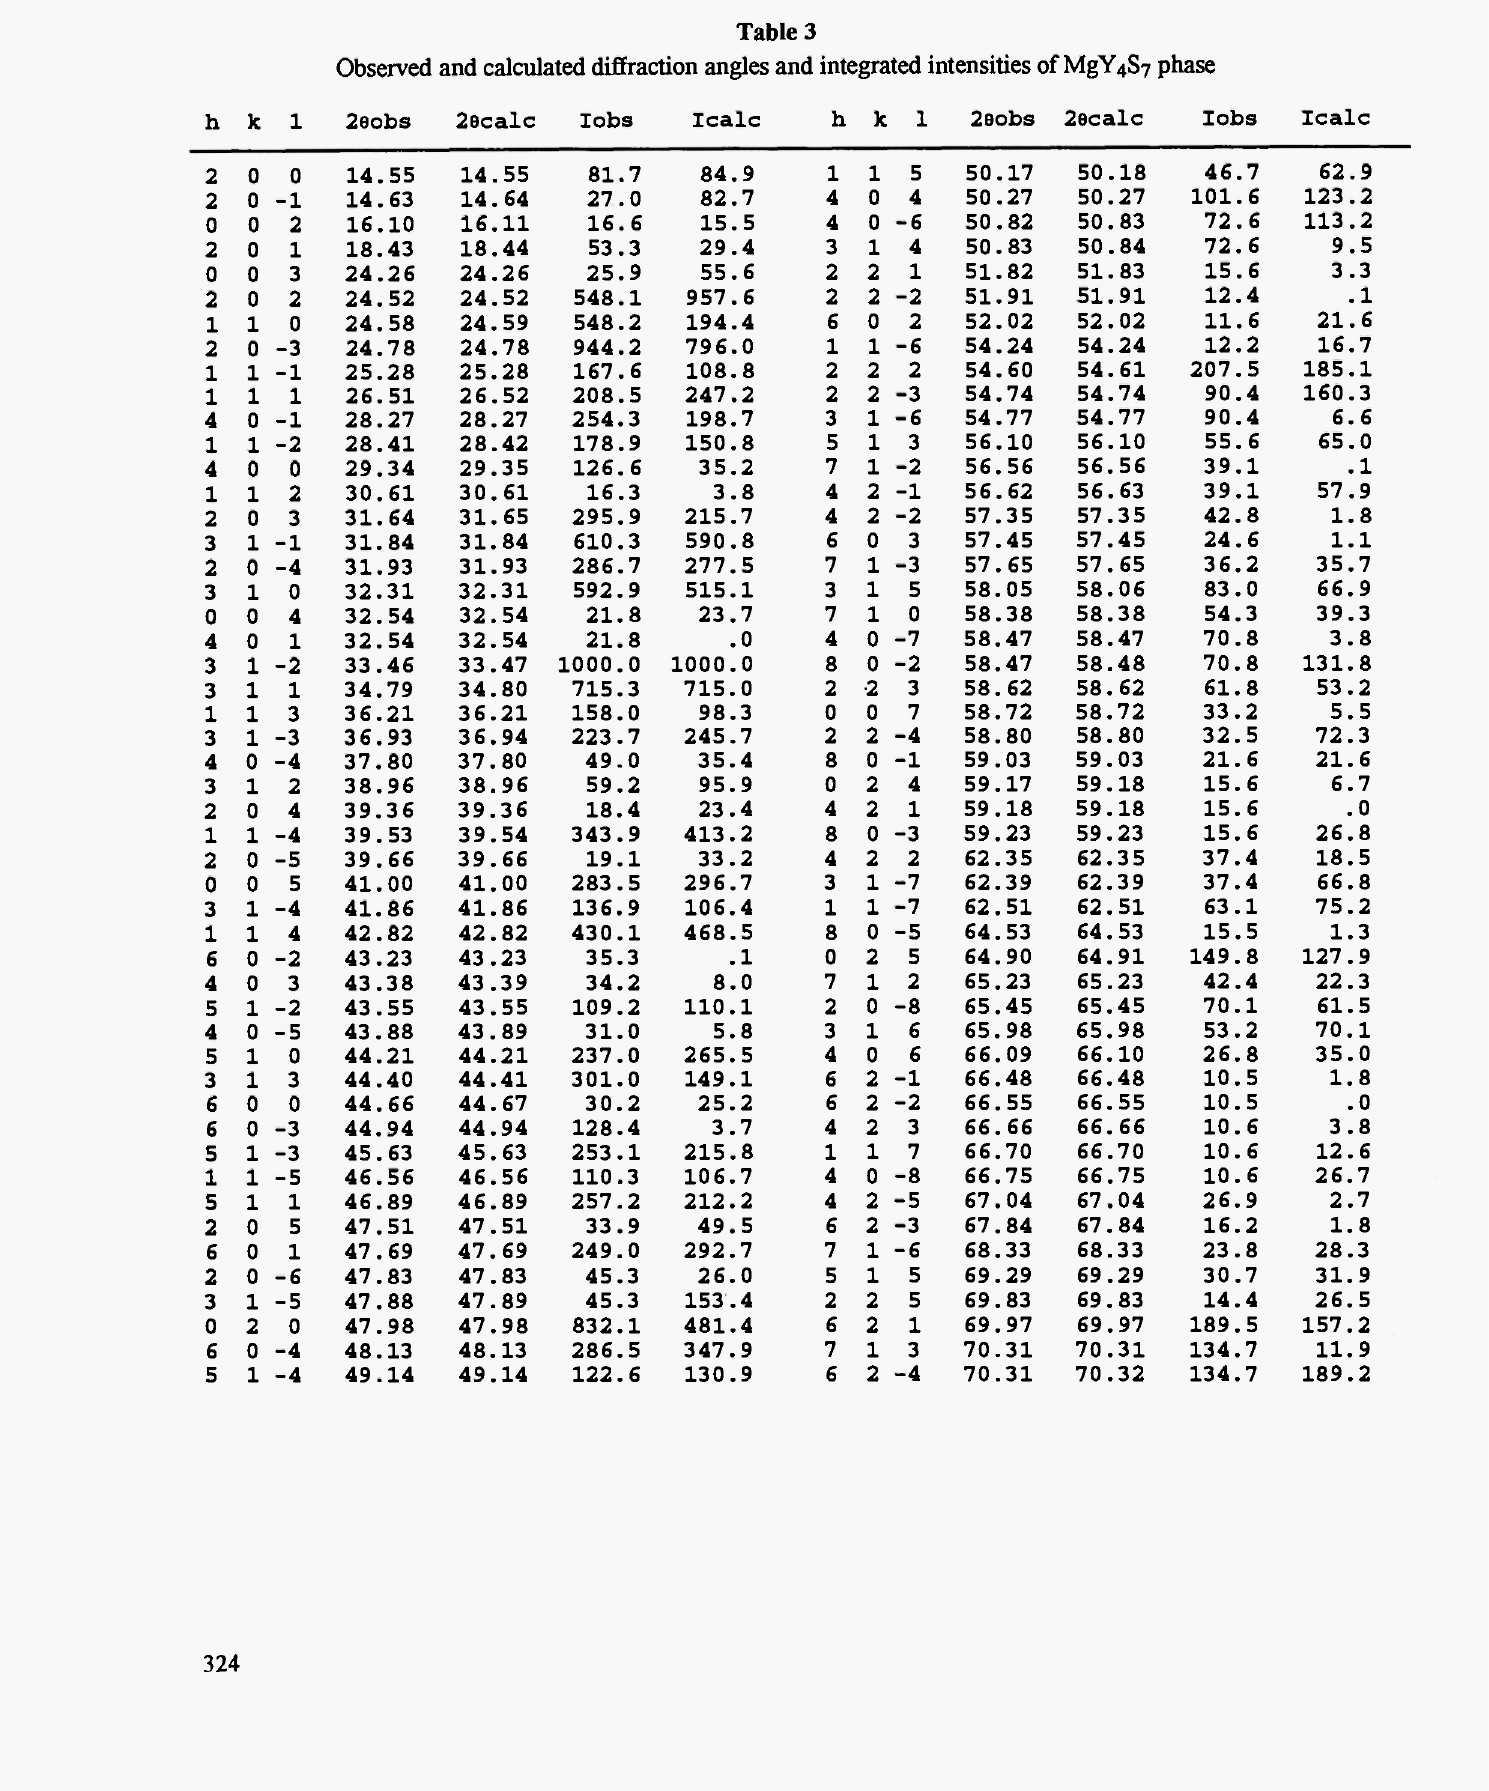
Observed and calculated diffraction angles and integrated intensities of MgY4S7